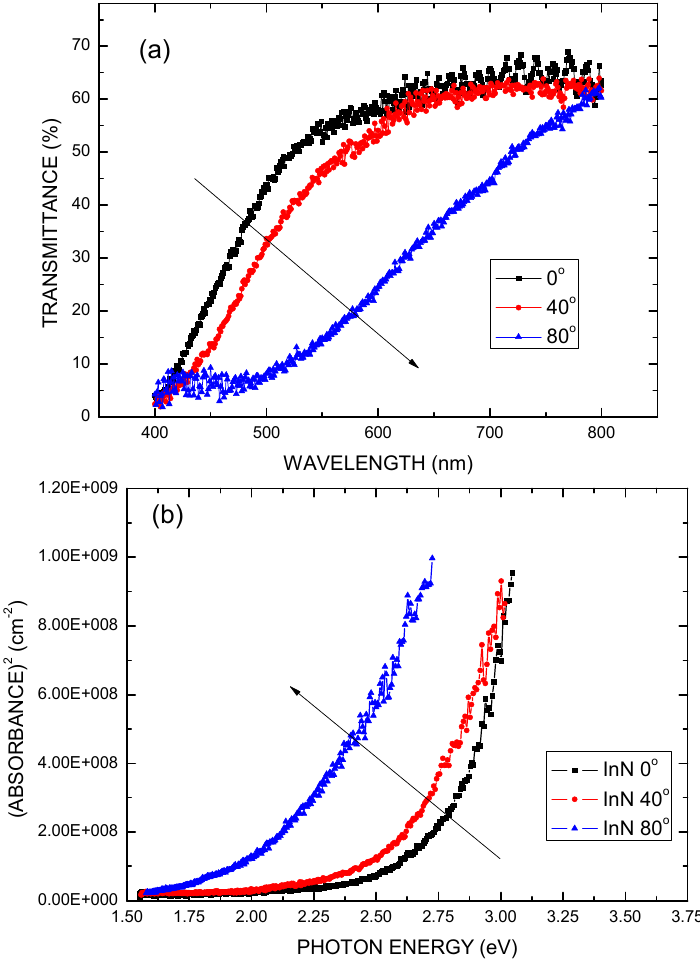
Figure 5. ( a ) Transmittance spectra of OAD-InN films deposited with various oblique-angles. ( b ) Relationship between absorbance squared and photon energy at room temperature for OAD-InN films.